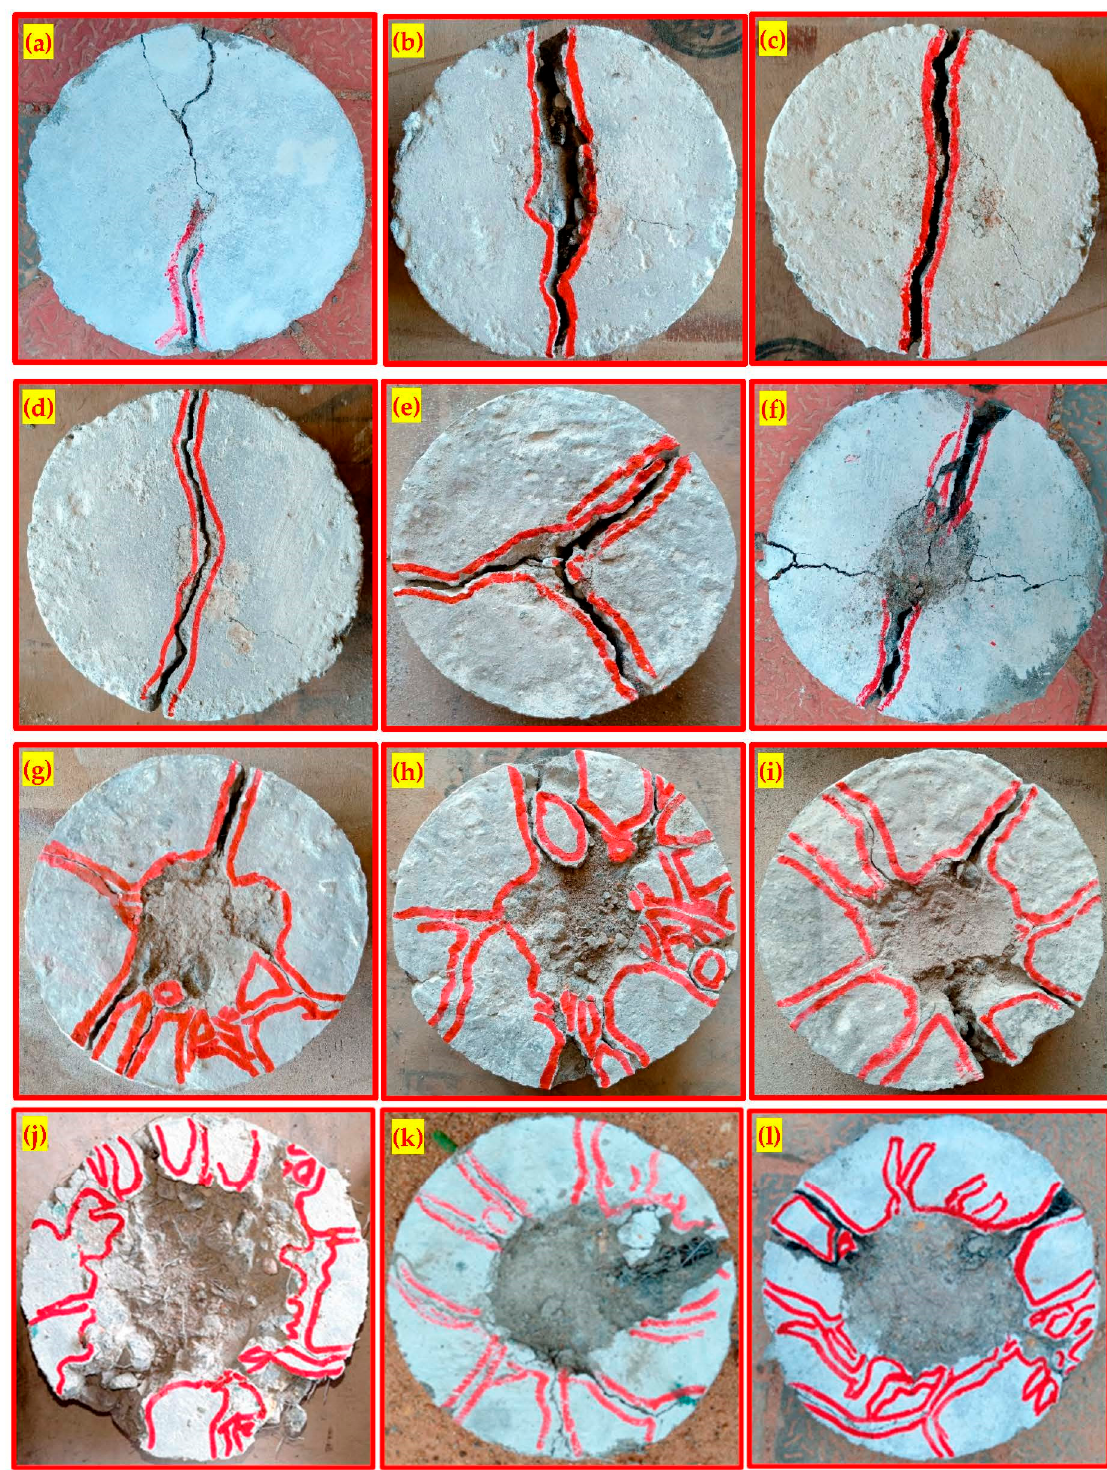
Figure 15. Failure pattern of PAFC. ( a ) CC, ( b ) G2-50, ( c ) G2-75, ( d ) G2-100, ( e ) G2-125, ( f ) G2-150, ( g ) FC, ( h ) FG2-50, ( i ) FG2-75, ( j ) FG2-100, ( k ) FG2-125 and ( l ) FG2-150.